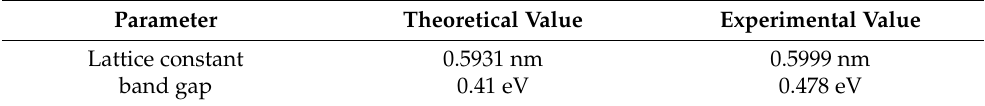
Table 2. Lattice constant and band gap of perfect galena.